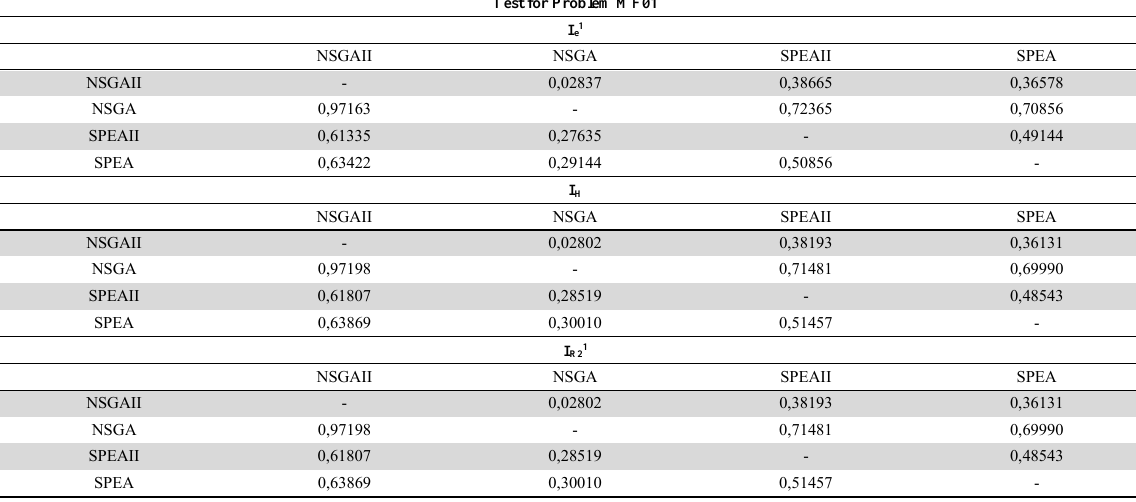
Unary epsilon indicator, unary hypervolume indicator and R indicator (MF01) Test for Problem MF01 I e1 NSGAII NSGA SPEAII